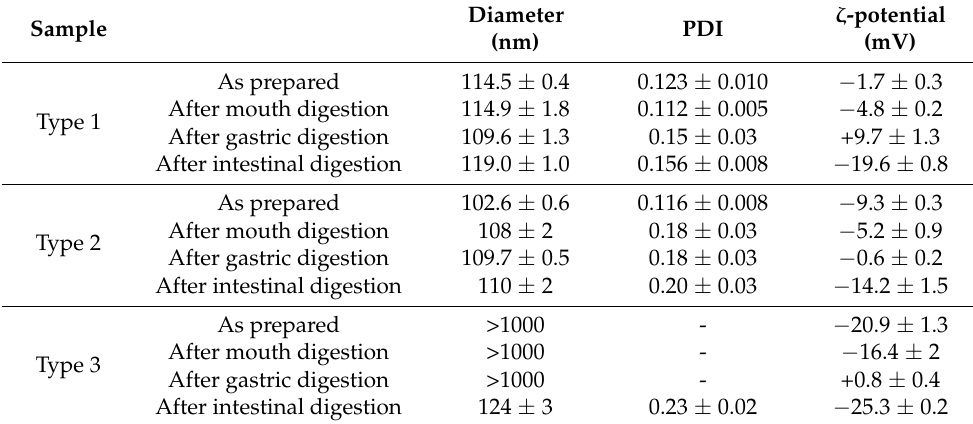
Figure 4. Enzymatic composition of the fluids, pH and incubation time characterizing each simulated in vitro digestive phase. Each digestive phase was carried out separately and at 37 °C. Liposomes/digestion fluids ratio was 1:3 V/V . Table 3. Liposome characterization as prepared and after each phase of simulated digestion. Liposomes were loaded with Cur and HT (40 µ M and 22 mM,